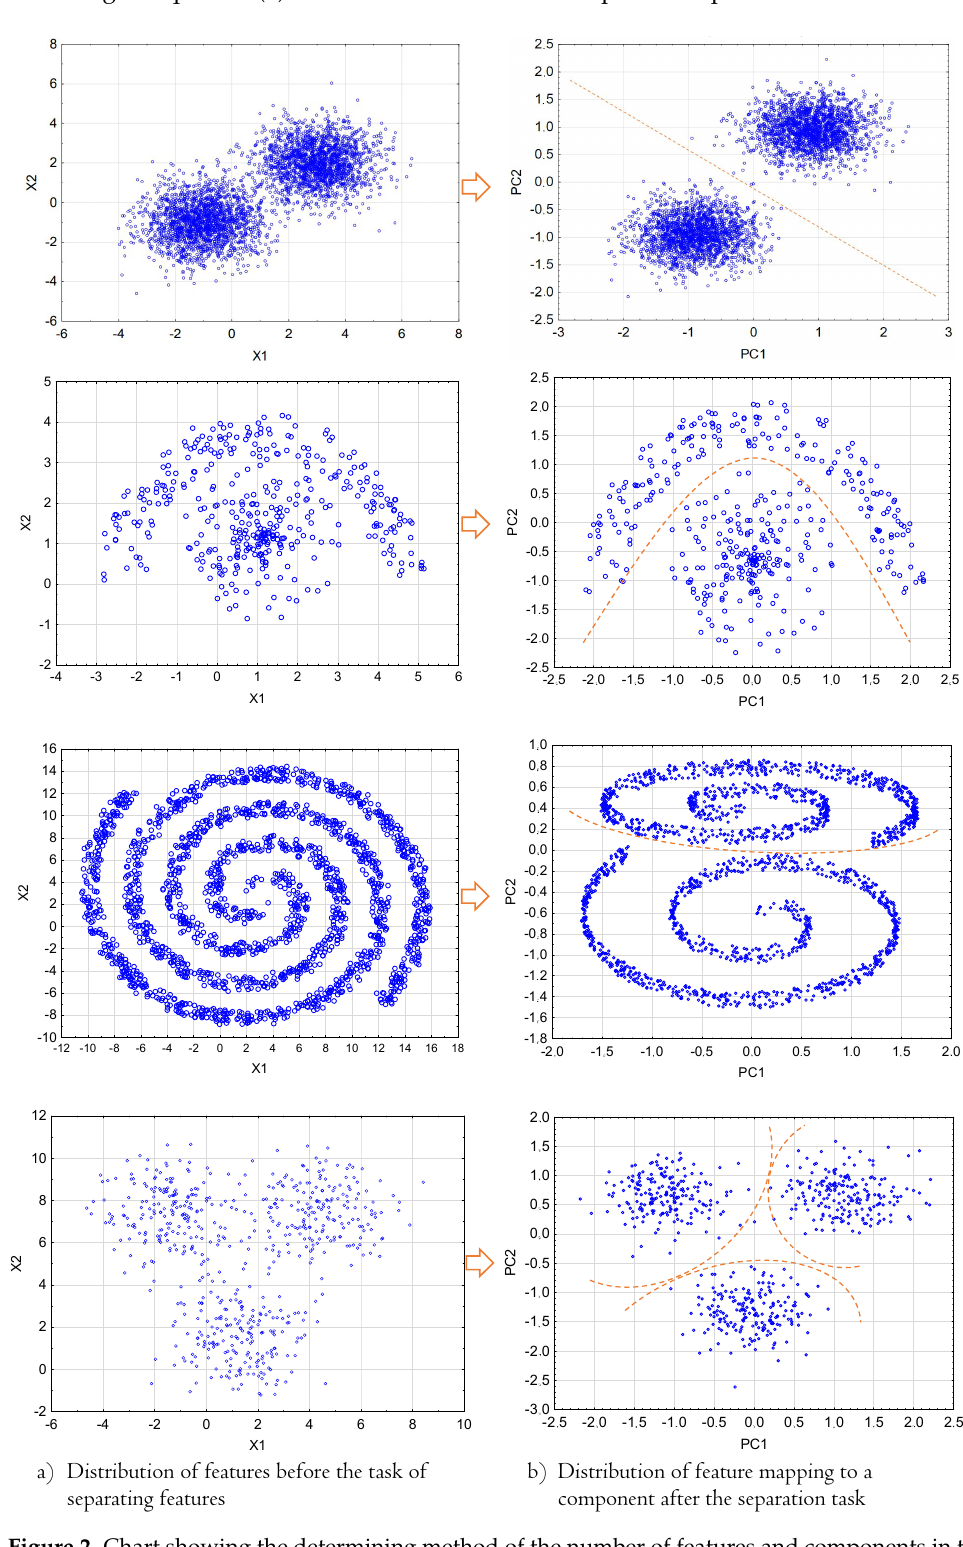
Figure 2 shows the principle of assigning features to one of the two components according to Equation (3) for a linear and nonlinear separation space.